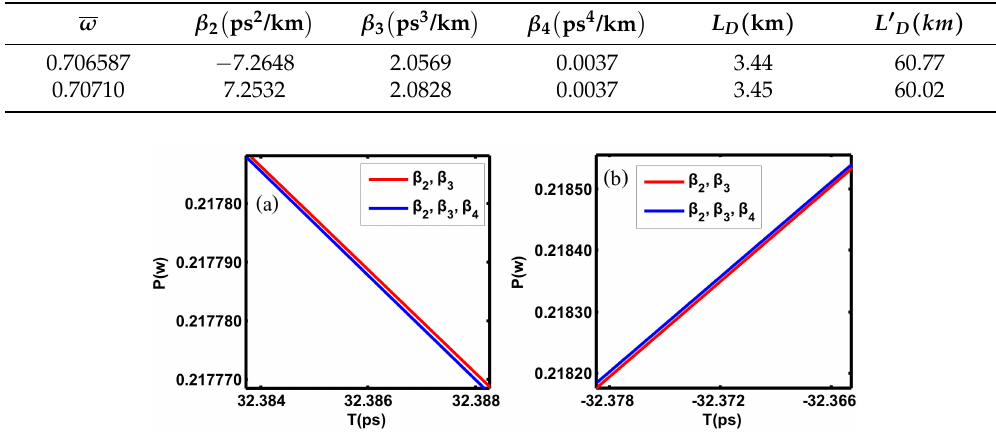
Figure 6. Magnification of the partial propagation waveform at FWHM for z = 21 km. ( a ) The first case in Table 3; and ( b ) the second case in Table